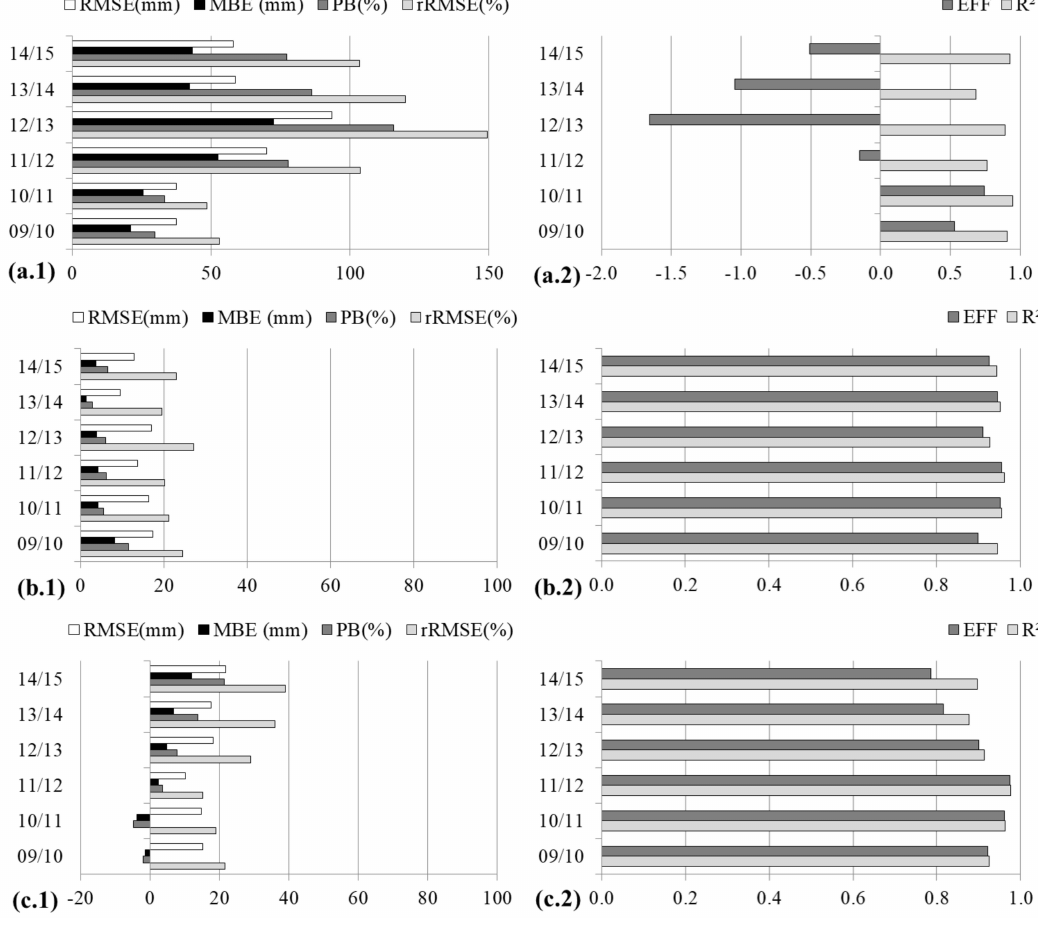
Figure 4. (a.1, b.1, c.1) Root mean squared error (RMSE), average of errors (MBE), relative root mean squared error (rRSME; %), and percent average of errors (PB; %); (a.2, b.2, c.2) Nash-Sutcliffe efficiency coefficient (EFF) and coefficient of determination (R 2 ) between the precipitation (PREC) data from the meteorological stations and estimates from ( a ) Eta, ( b ) TRMM, and ( c )